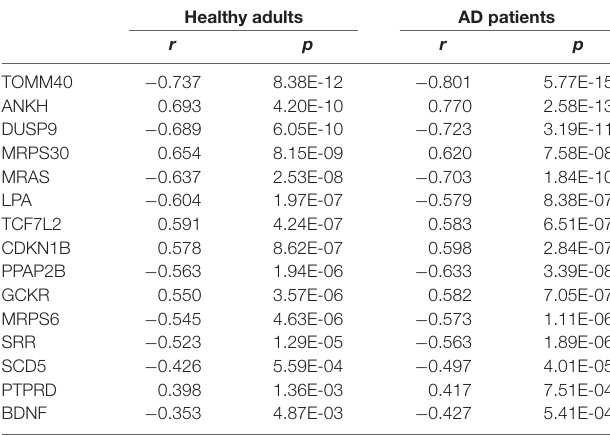
TABLE 1 | Characteristics of study participants. TABLE 2 | Correlation between type 2 diabetes risk genes and brain standardized values (SUVR)